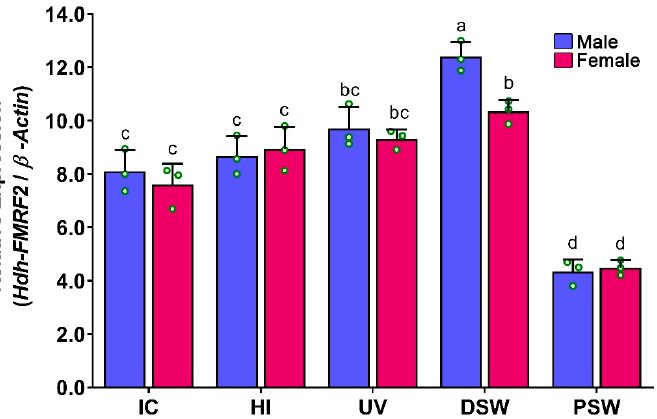
Figure 10. Changes in mRNA expression levels of Hdh-FMRF2 in the cerebral ganglion during different steps of induced spawning events of Pacific abalone in both sexes. For all bar graphs, the raw data points (green circle) represent biological replicates, the error bars represent the standard error of the mean (SEM), and different letters above the bars indicate significant differences ( p < 0.05) among the steps of induced spawning event. IC, initial control; HI, heat induced; UV, UV-irradiated water induced; DS, during spawning, AS, after spawning.